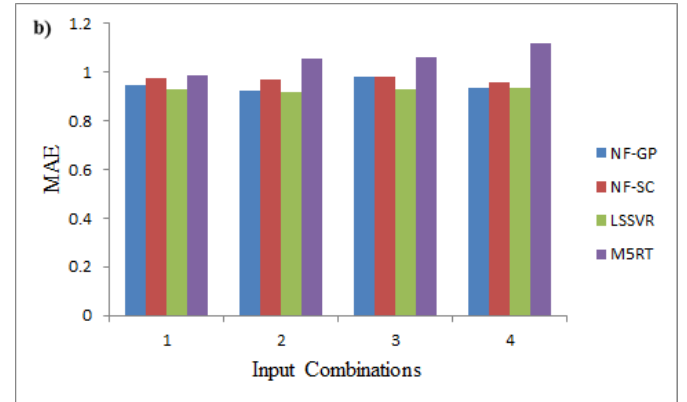
Figure 5. Average ( a ) RMSE and ( b ) mean absolute error (MAE) of the applied models in predicting wind speed for all input combinations.